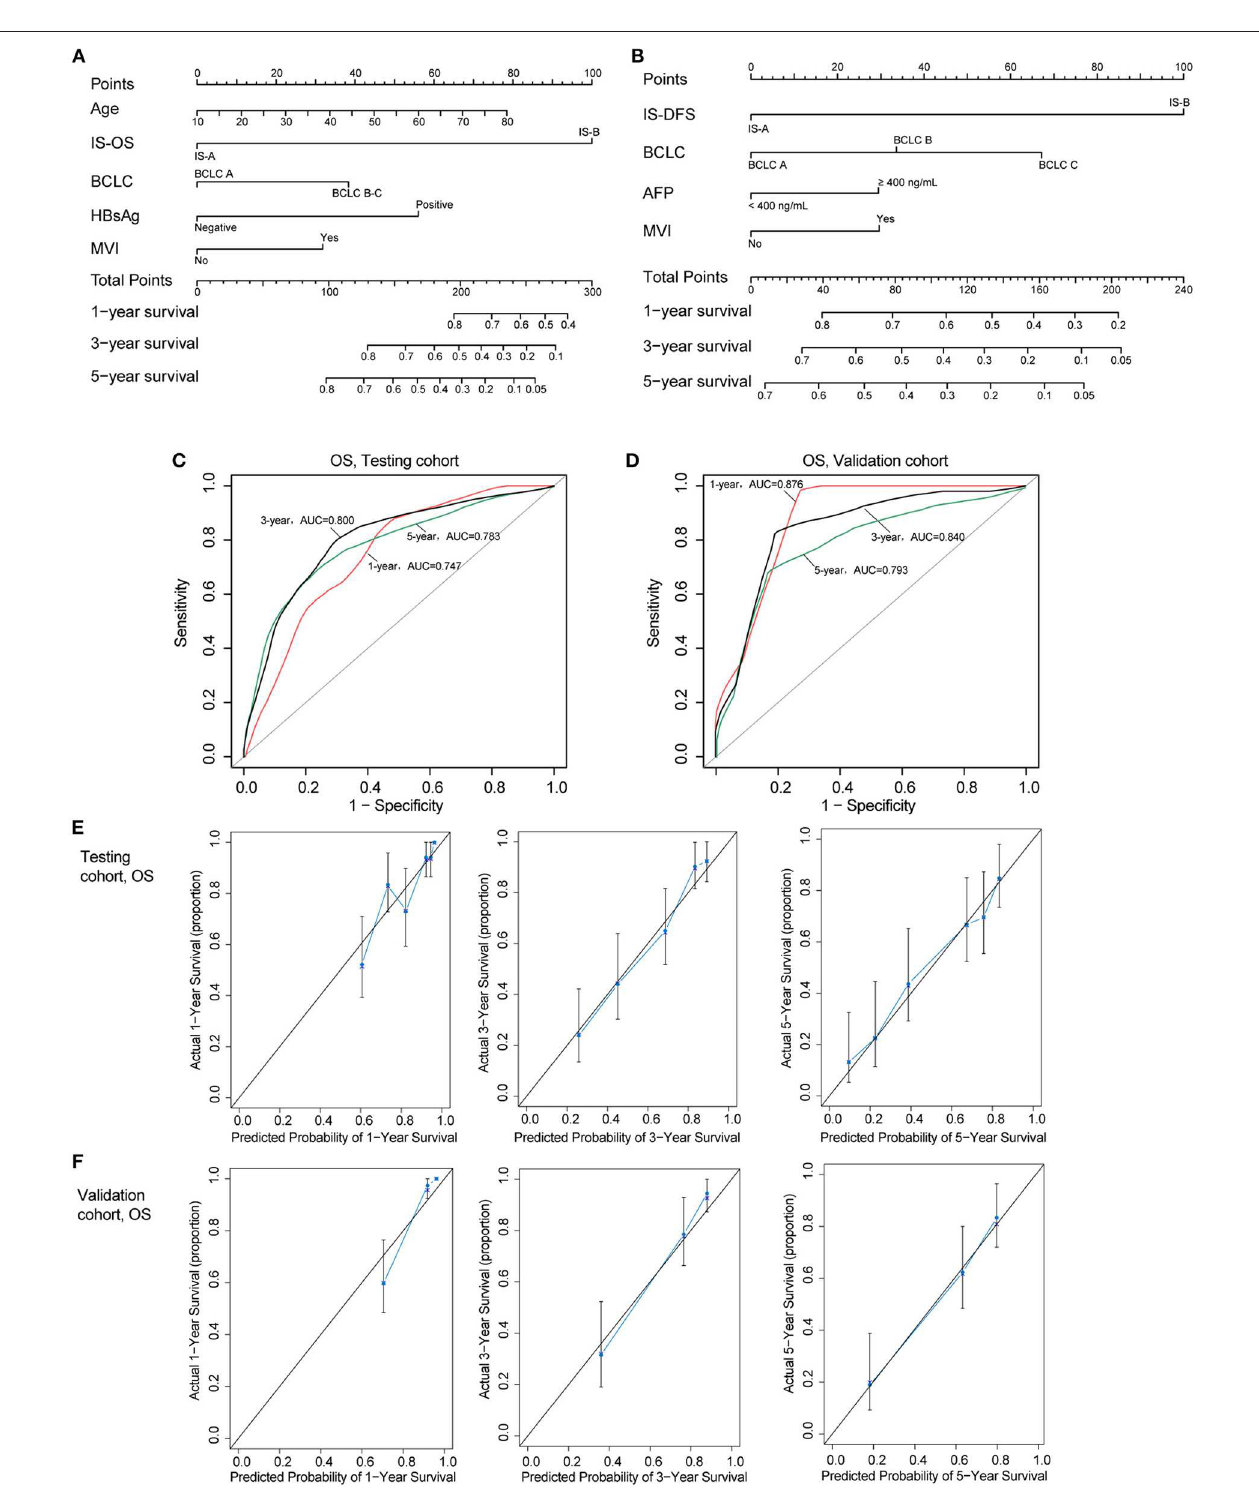
FIGURE 4 | (A,B) Nomograms (for OS and DFS) that integrated the immune type and clinicopathologic risk factors. To calculate the probability of status, sum up the points identified on the scale for all the variables and draw a vertical line from the total points scale to the probability scale. (C,D) ROC curves showing the predictive accuracy (1-, 3-, 5-year AUC) of the nomogram for OS in testing and validation cohorts. (E,F) Calibration curves showing the discriminatory power of the nomogram for OS in testing and validation cohorts.